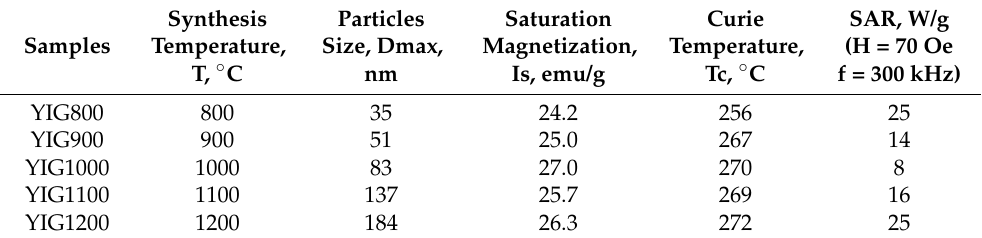
Table 1. Temperature of sample synthesis and particle properties.